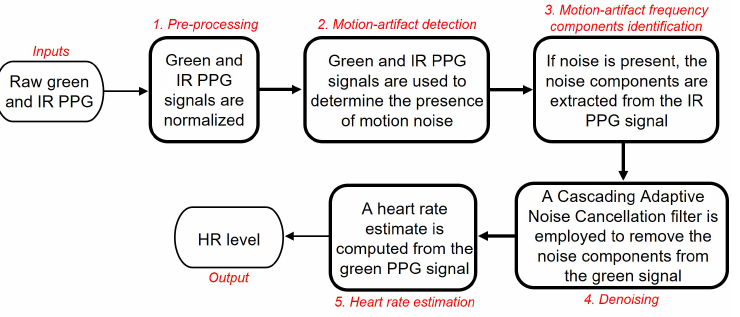
Figure 1. Summary of the DWL